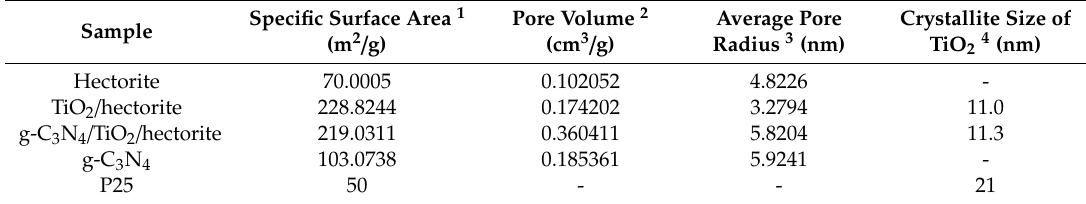
Table 2. The specific surface area, pore volume, pore diameter and crystallite size of TiO 2